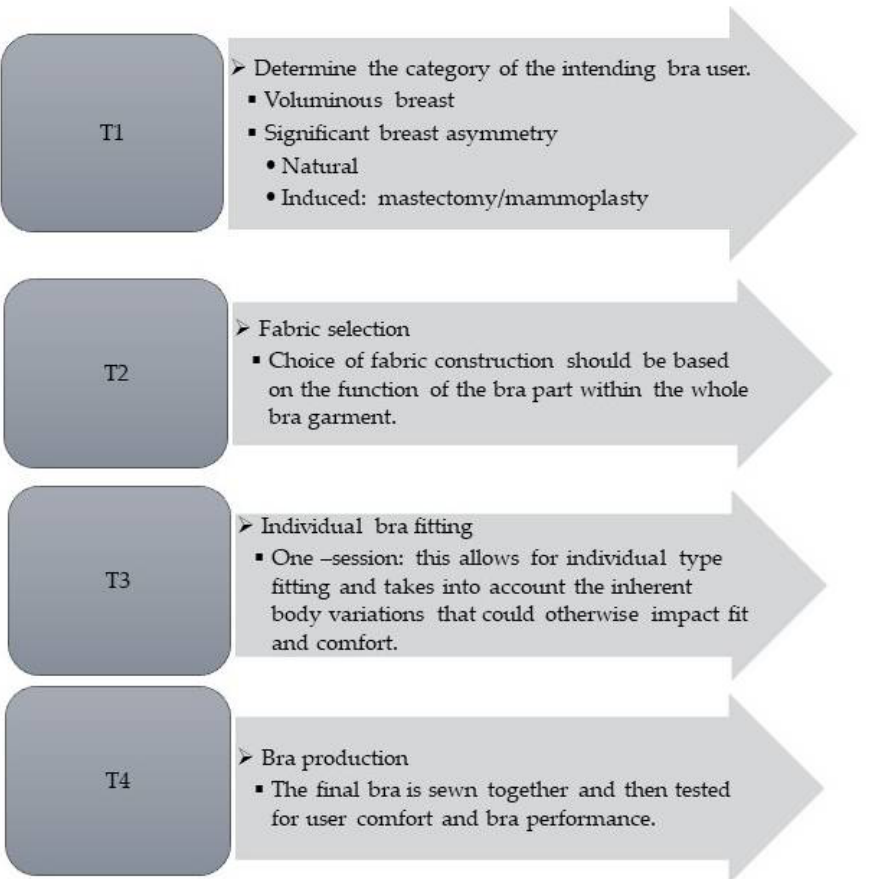
Figure 3. Translational pathway to bras well suited to those with atypical breast shape/size.